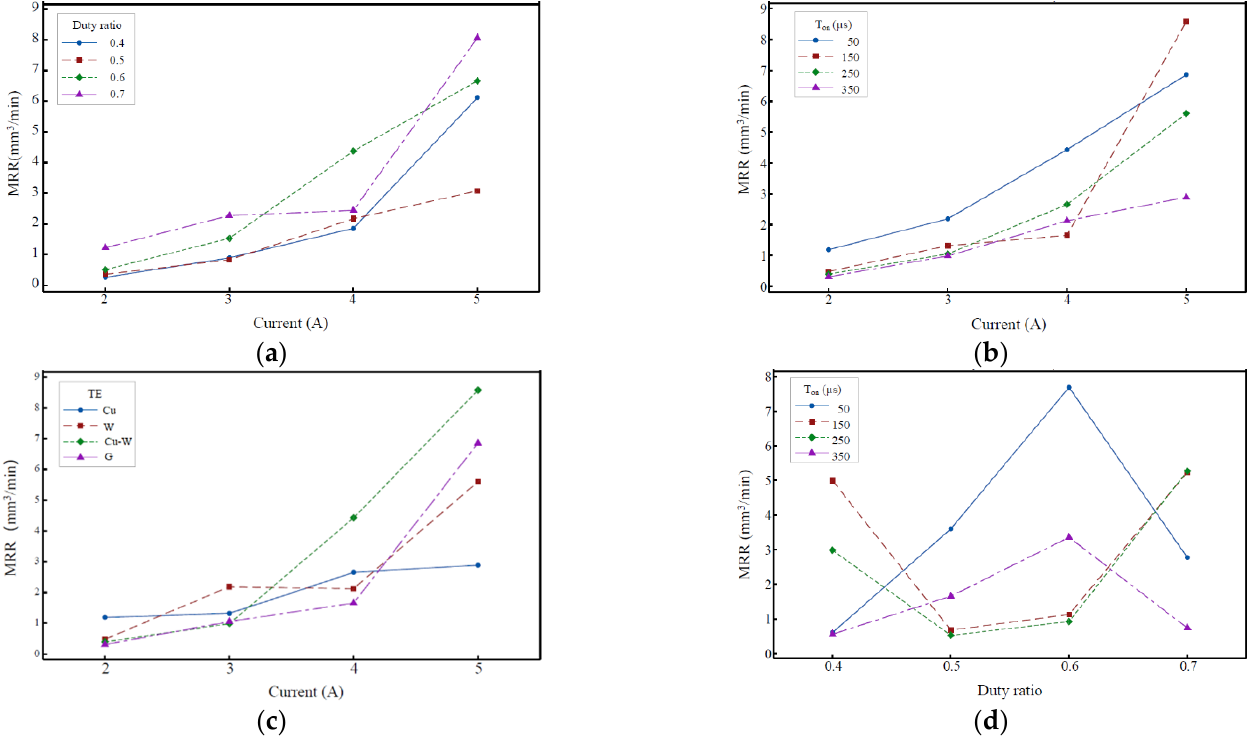
Figure 9. Interaction effect on MRR; ( a ) current and duty ratio on MRR; ( b ) current and pulse duration on MRR; ( c ) current and tool electrode on MRR; ( d ) duty ratio and pulse duration on MRR.